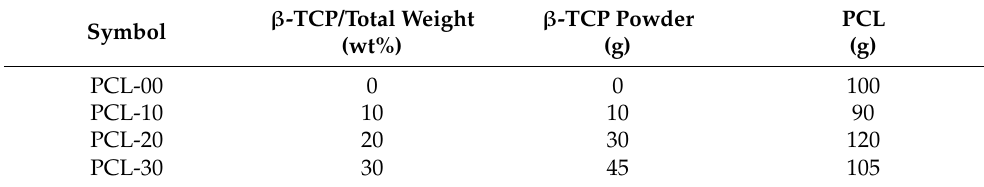
Table 1. PCL/ β -TCP filament weight